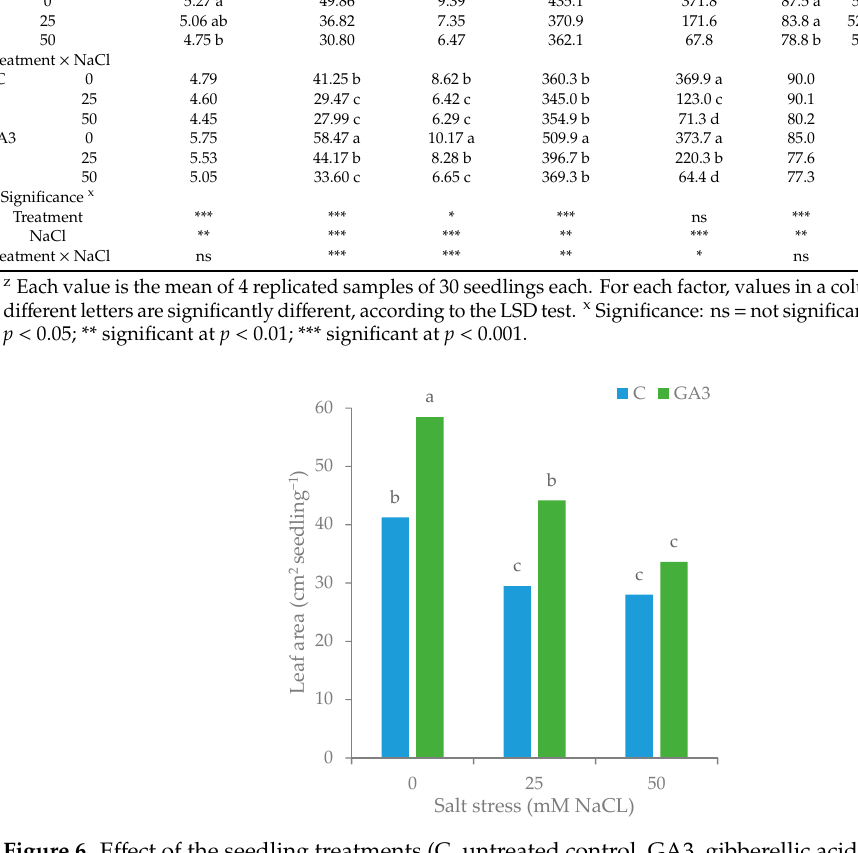
Table 2. Effects of the gibberellic acid treatment (C, not treated; GA3, GA 3 -treated seedlings) and salt stress (0, 25, and 50 mM NaCl in the irrigation water) on leaf characteristics of tomato seedlings.